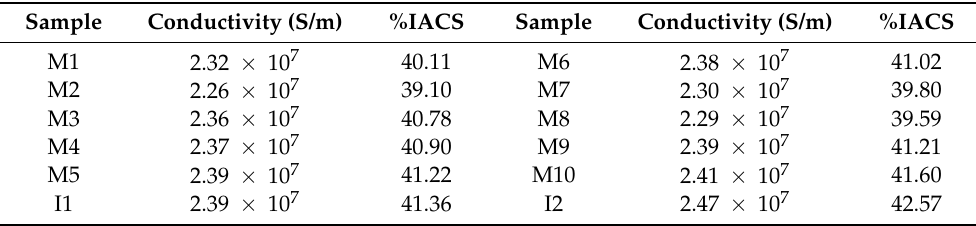
Table 3. Micro-hardness, tensile and yield strength values of SPS Al-based